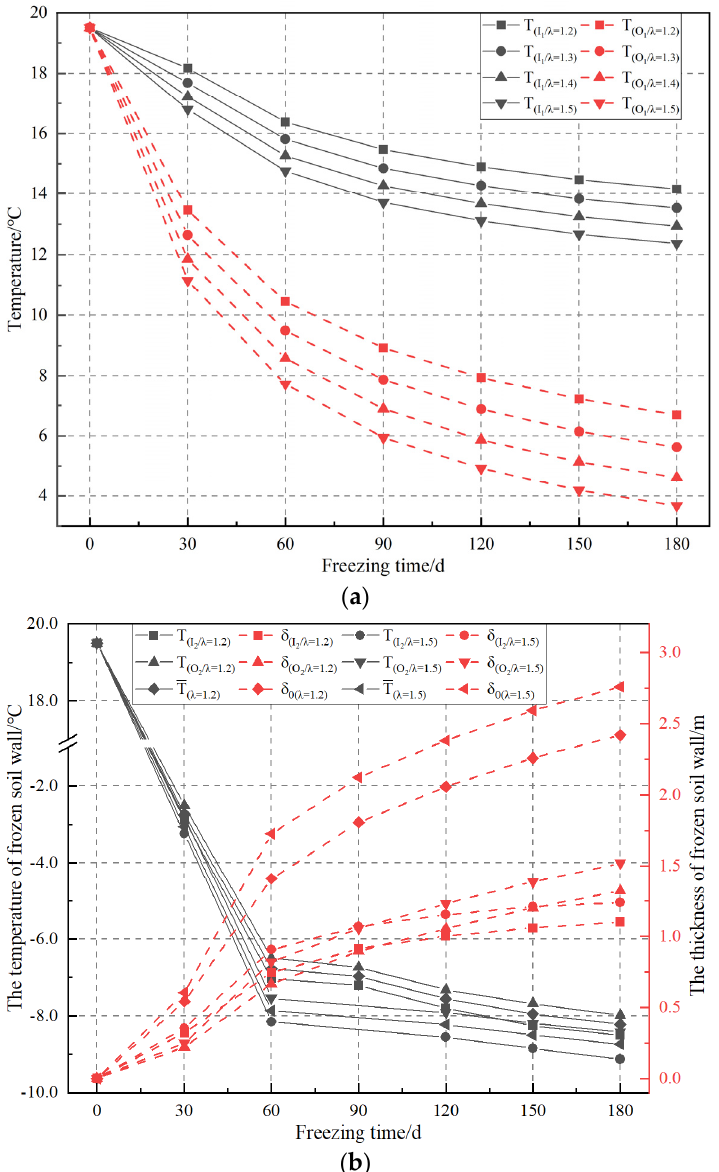
Figure 16. Variance in temperature and thickness under different thermal conductivities of unfrozen soil and freezing time: ( a ) temperature in interlayer and outside wall of shaft, ( b ) temperature and thickness in the inside and outside of frozen soil wall and its average or sum value with thermal conductivities of unfrozen soil of 1.2 W · m − 1 · ◦ C − 1 and 1.5 W · m − 1 · ◦ C − 1